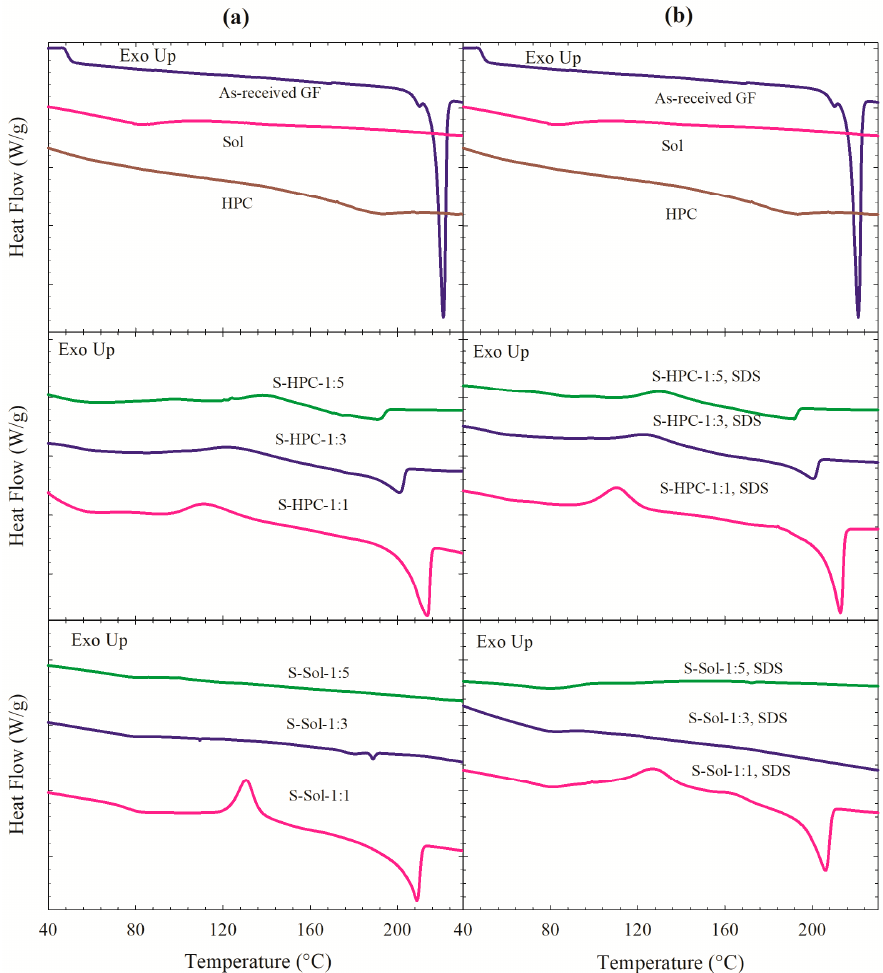
Figure 3. DSC traces of as-received GF, HPC, Sol, and the spray-dried powders prepared using the GF solutions with 1:1, 1:3, and 1:5 drug:polymer mass ratios: ( a ) without SDS and ( b ) with 0.125% SDS.